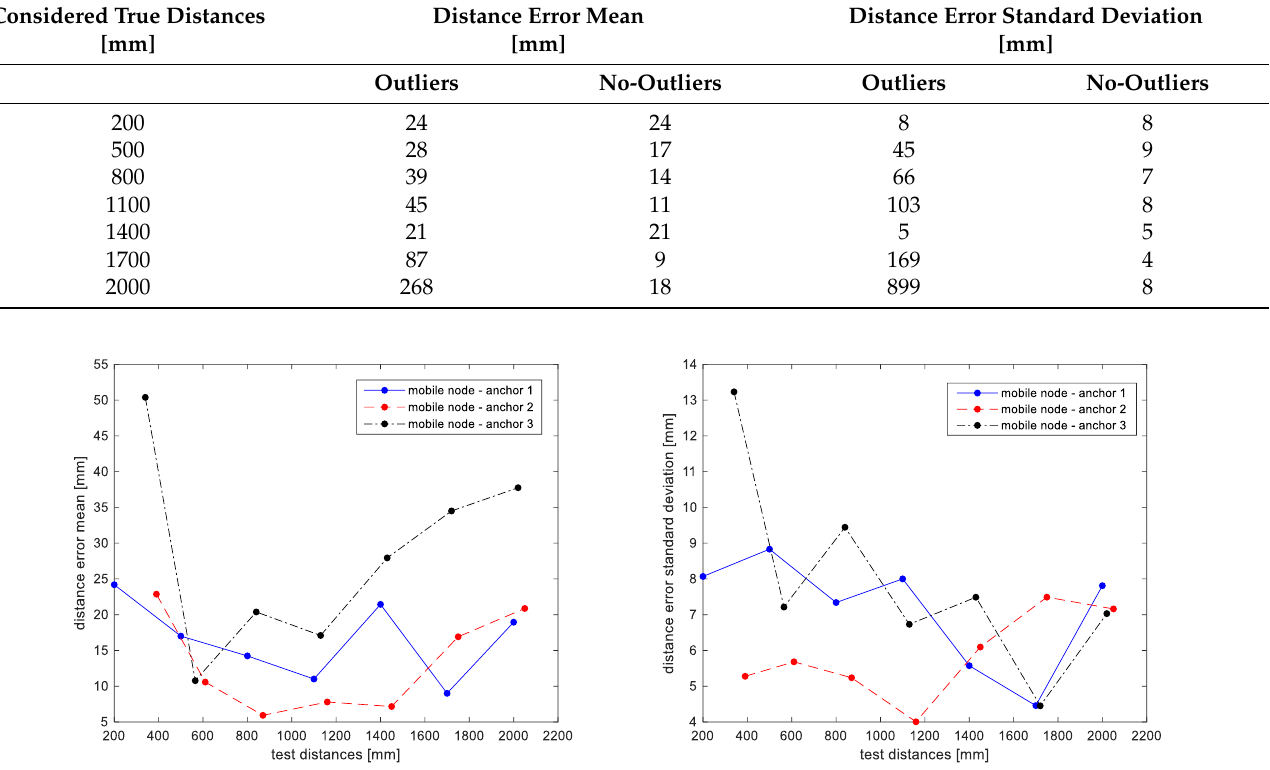
Figure 7. Distance error mean ( left ) and standard deviation ( right ) for each considered couple of nodes after outlier